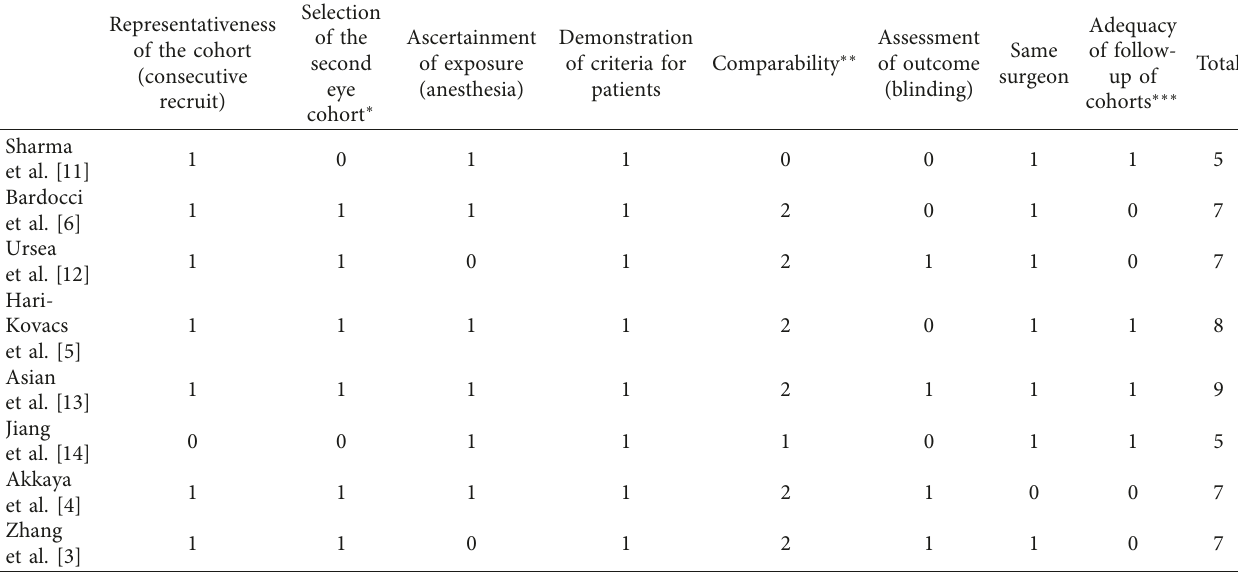
Table 2: Score of quality of included